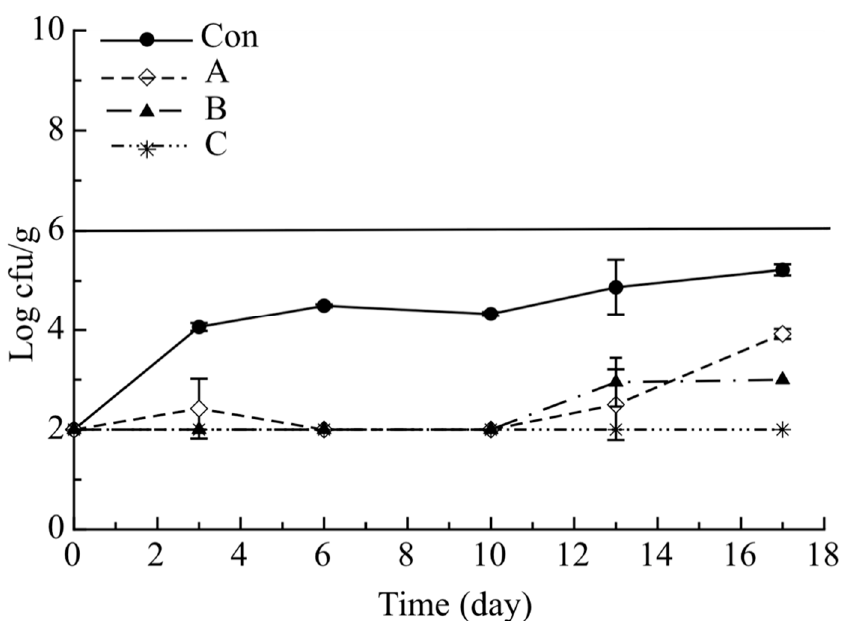
Figure 3. Evolution of Shewanella in the breaded cod sticks during storage at 4 °C. Data are presented as mean ± SD ( n = 2). Symbols: experimental data; Solid Line: threshold for microbial acceptability set to 10 6 log cfu/g. Con: sticks breaded with sole no active mix; A: sticks breaded with sole active mix; B: sticks breaded with pomegranate peel powder/no active mix; C: sticks breaded with pomegranate peel powder/active mix.